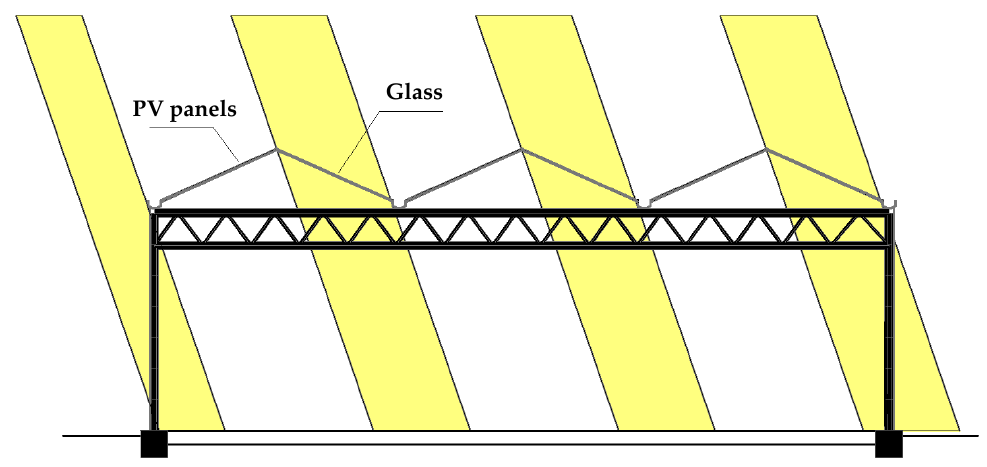
Figure 2. Direct solar radiation at Mediterranean latitudes: 21 June, 12:00 pm. (PV: photovoltaic).